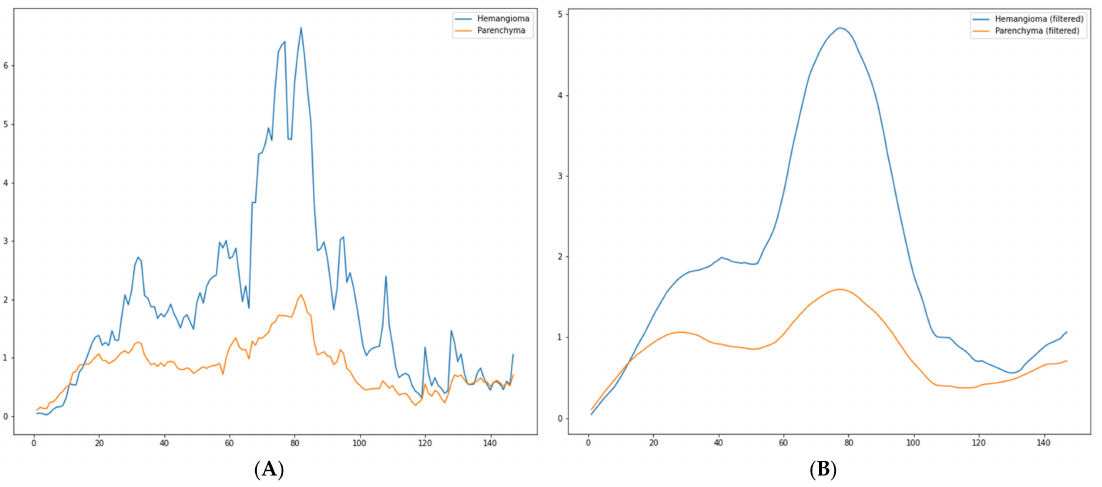
Figure 7. ( A )—Raw TIC extracted with the proposed method; ( B )—filtered TIC extracted with the proposed method (patient diagnosed with hemangioma).